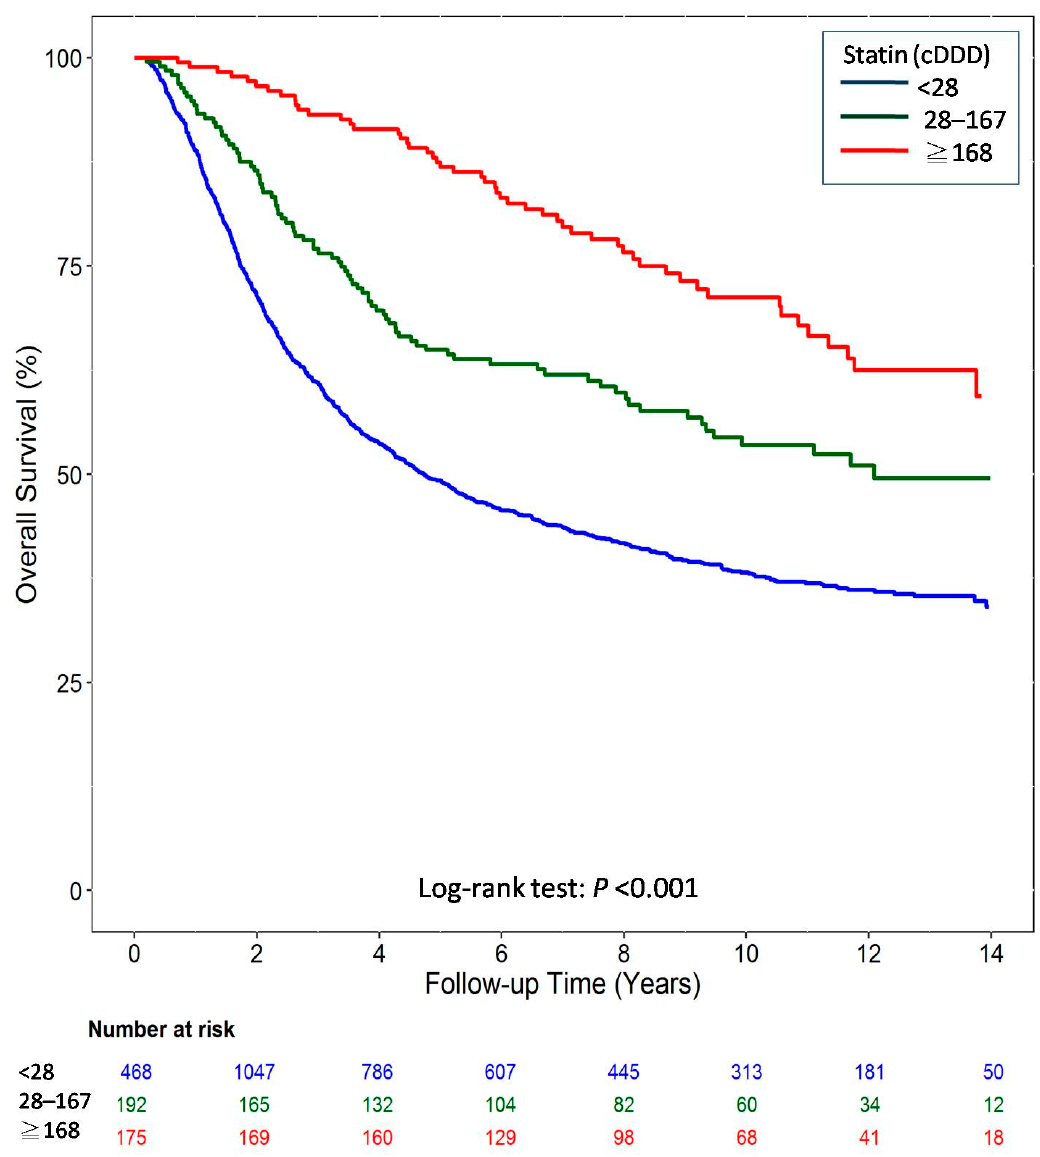
Figure 2. Overall survival of gastric cancer patients after surgery and adjuvant chemotherapy by cumulative defined daily dose (cDDD) of statin use during the follow-up period from the matched cohort.